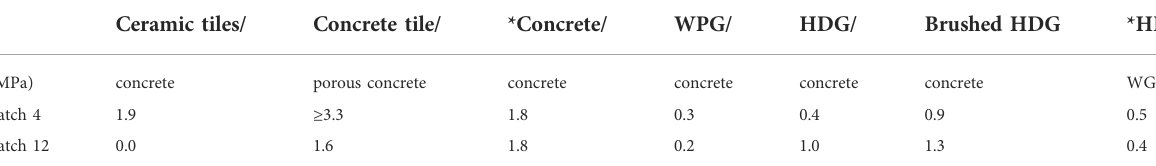
TABLE 5 Three (*) or 7 day pull off strengths of test {C} of the adhesives batch 4 and 12 bonding the respectively stated components.